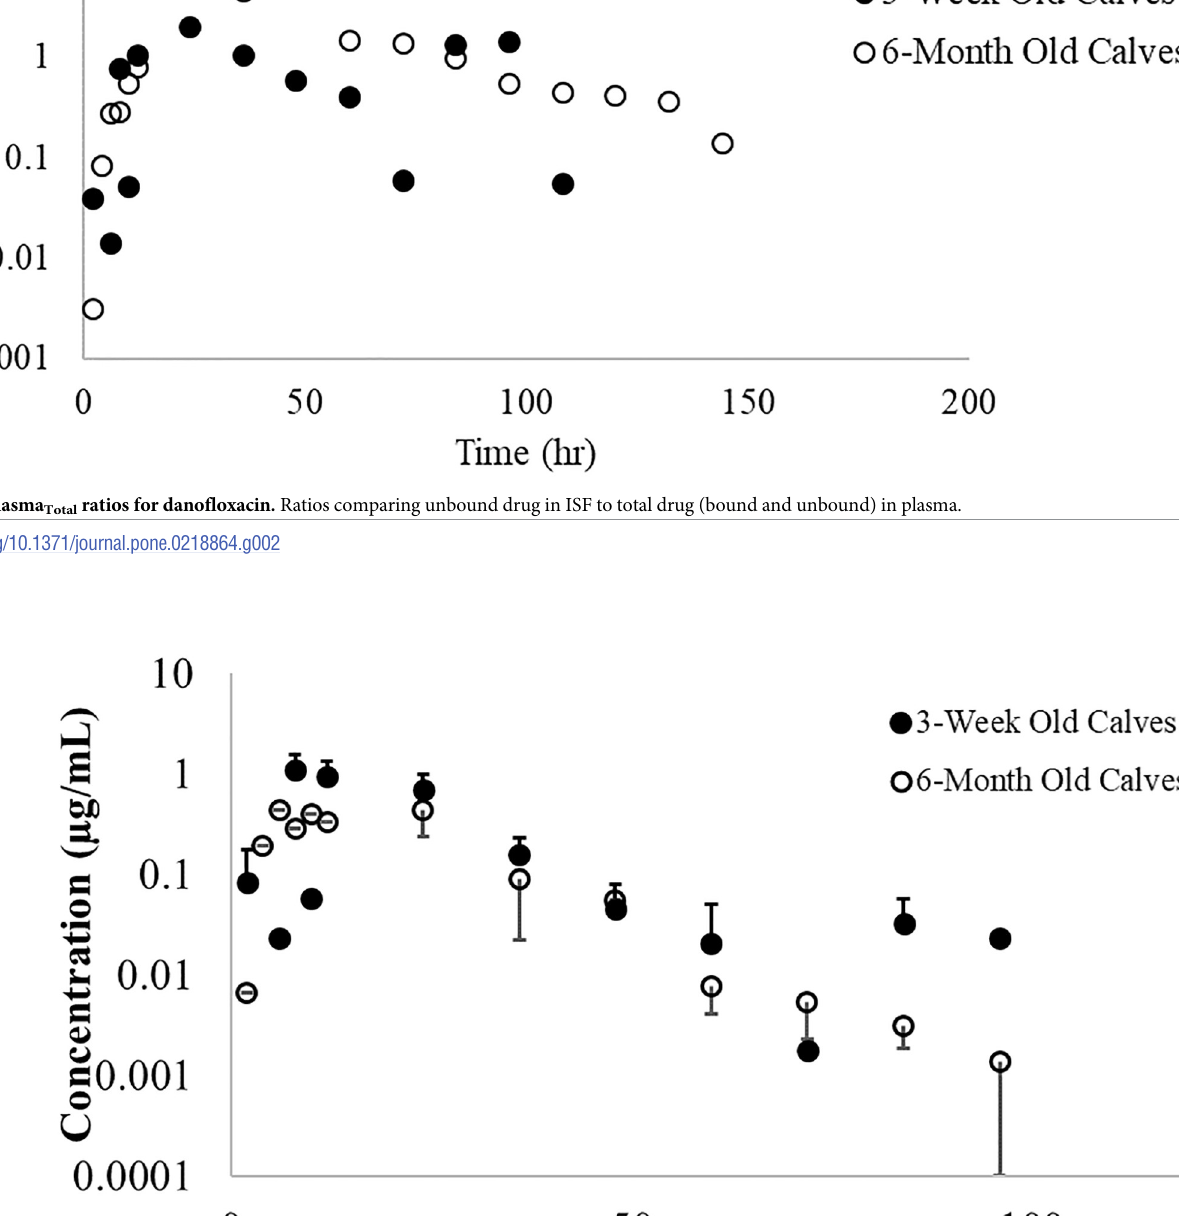
PLOS ONE | https://doi.org/10.1371/journal.pone.0218864 June 24, 2019 10 /